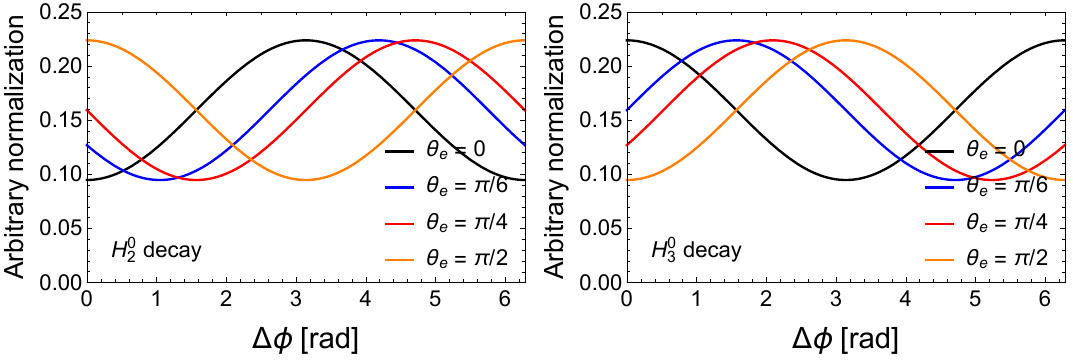
Figure 9 . Normalized (cid:1) (cid:30) distributions for H 0